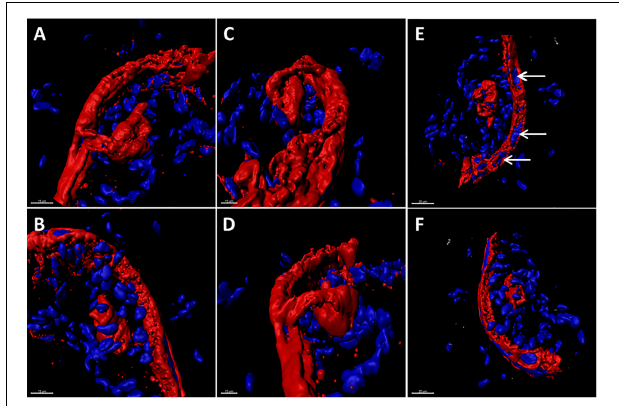
FIGURE 2 | The true late phase of the VZV-infectious cycle in human skin explants. At 14 dpi, VZV infection was analyzed by confocal microscopy with subsequent creation of 3D animations of infected SOC by merging the z-stacks with Imaris software. In order to document that viral replication had entered the late phase of the VZV infectious cycle in human skin, the infectious foci in the skin were immunolabeled with antibody to the true late VZV gC glycoprotein (red color). Six different orientations of the infectious focus are shown in panels A–F . In panel E , VZV-induced syncytia are visible as clusters of nuclei surrounded by the gC glycoprotein (white arrows). Nuclei are colored blue by the Hoechst